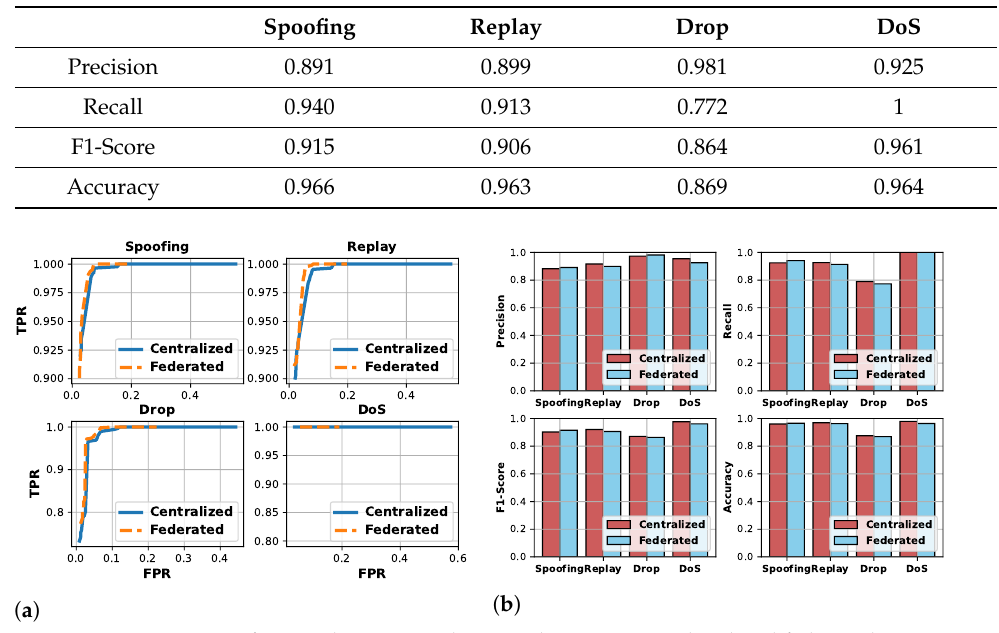
Figure 9. Comparison of network intrusion detection between centralized and federated ConvLSTM- based methods: ( a ) ROC curve, ( b ) precision, recall, F1-score, and